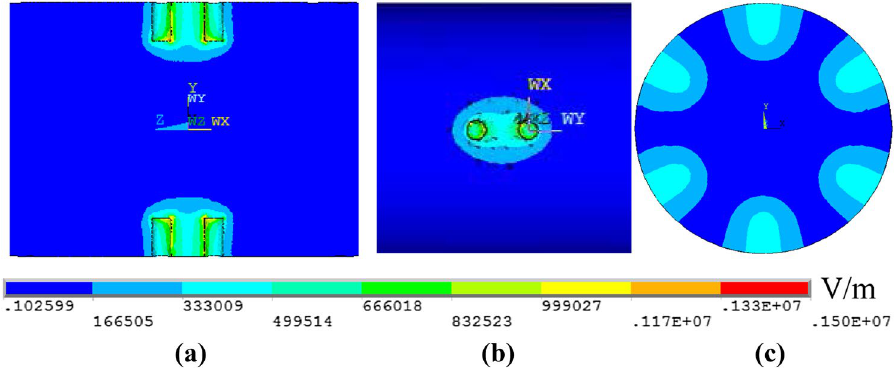
electric field distribution of MCPA: a YoZ plane sectional view; b XoZ plane sectional view; c XoY plane sectional